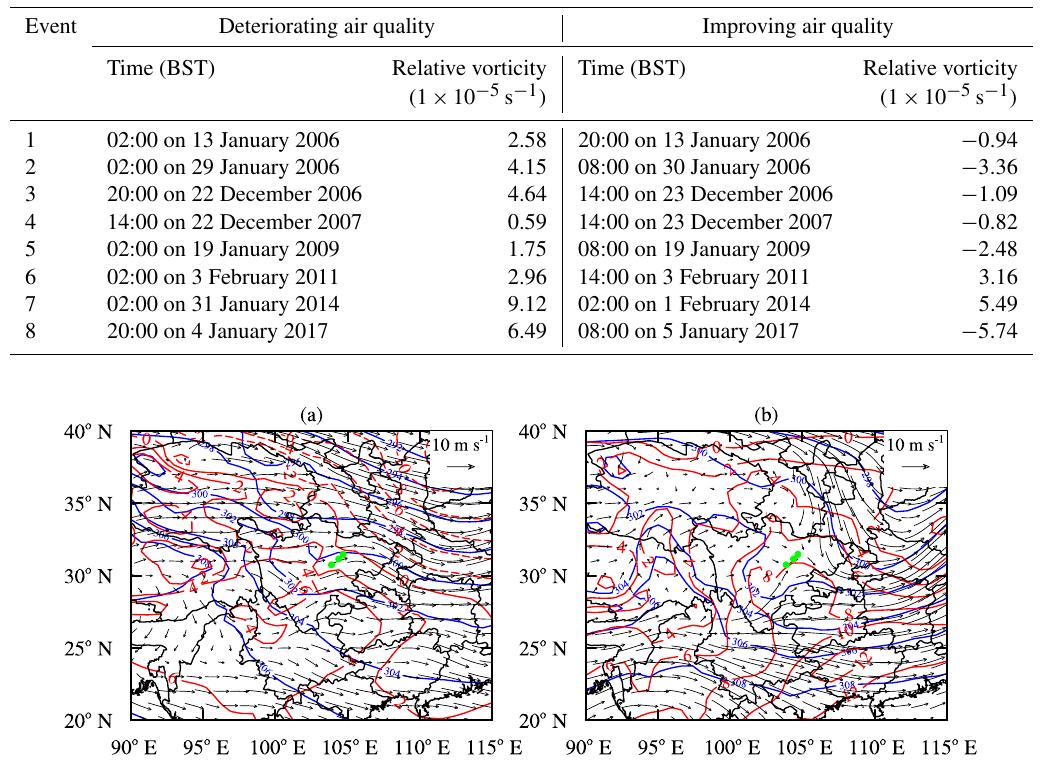
Table 2. Relative vorticity at 700hPa during the periods of deteriorating and improving air quality in each of the eight heavy air pollution events.